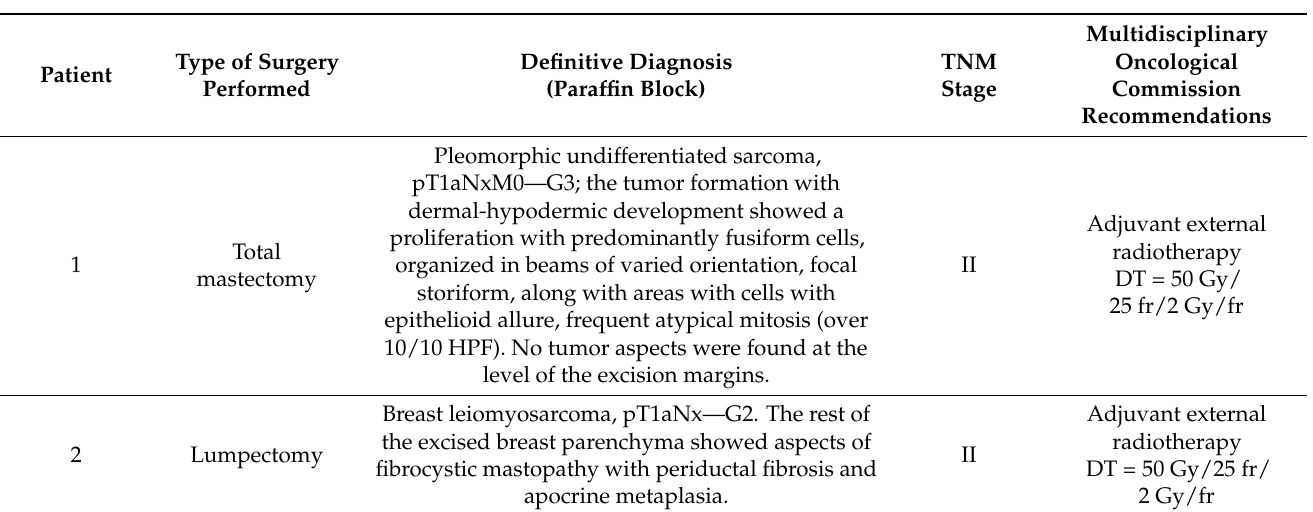
Table 3. Type of surgery, definitive pathological exam results and cancer committee recommendations in breast